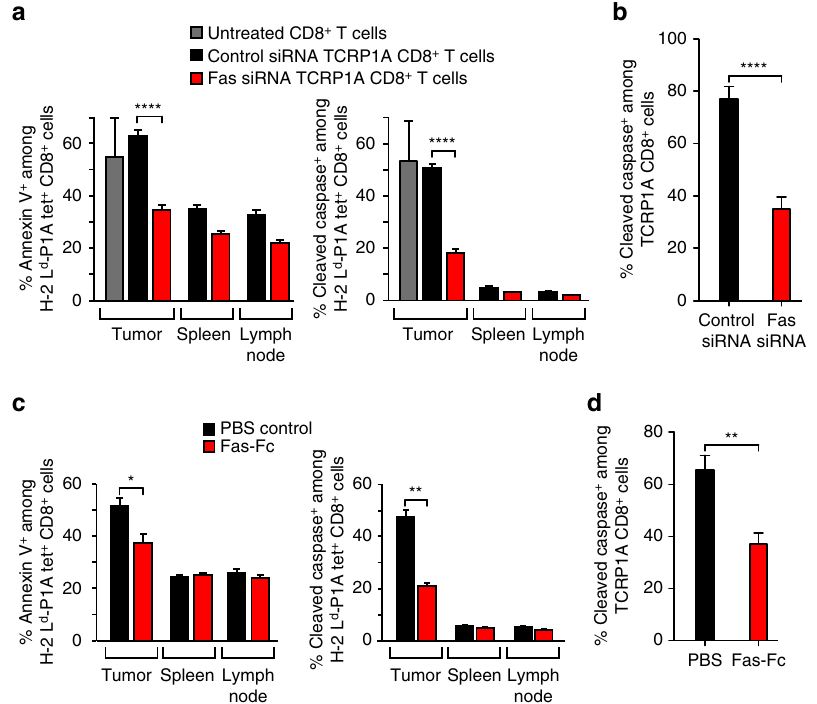
Fig. 5 TIL apoptosis is triggered by FasL. a Tumor-bearing TiRP mice were transferred with 10 7 activated TCRP1A CD8 + T cells treated with either